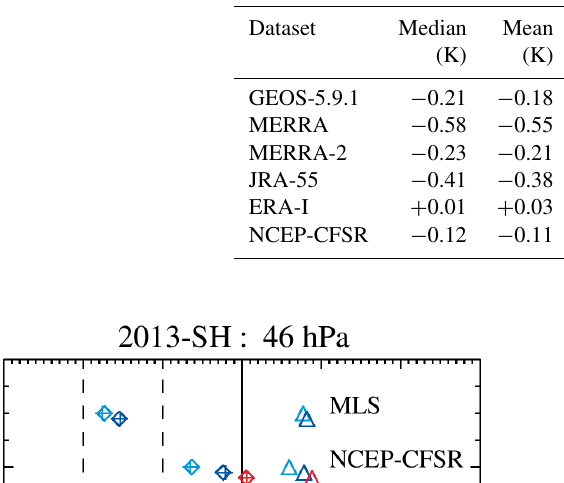
Table 3. The same as for Table 2, except for ICE PSCs relative to the theoretical ice frost point temperature (3288 profiles).